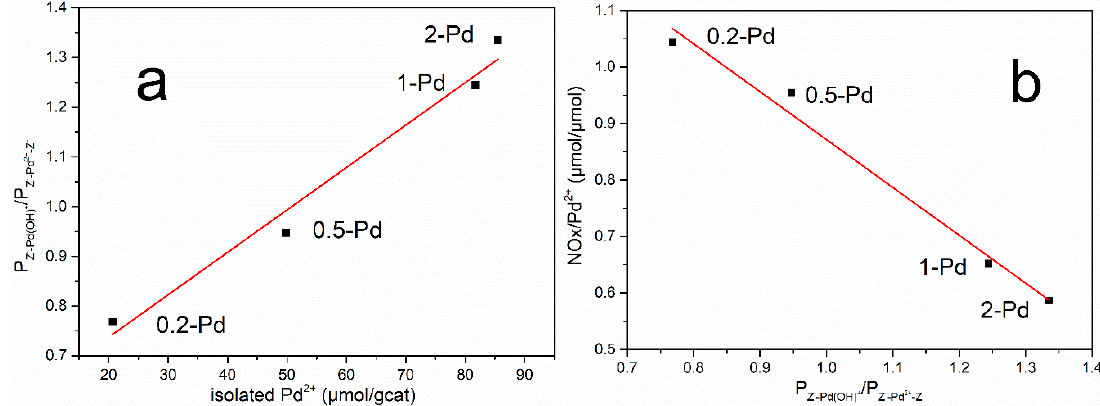
Figure 5. ( a ) tendency between isolated Pd 2+ and P Z − - Pd(OH)+ /P Z − - Pd2+ - Z − ; ( b ) tendency between P Z − - Pd(OH)+ /P Z − - Pd2+ - Z − and NO x /Pd